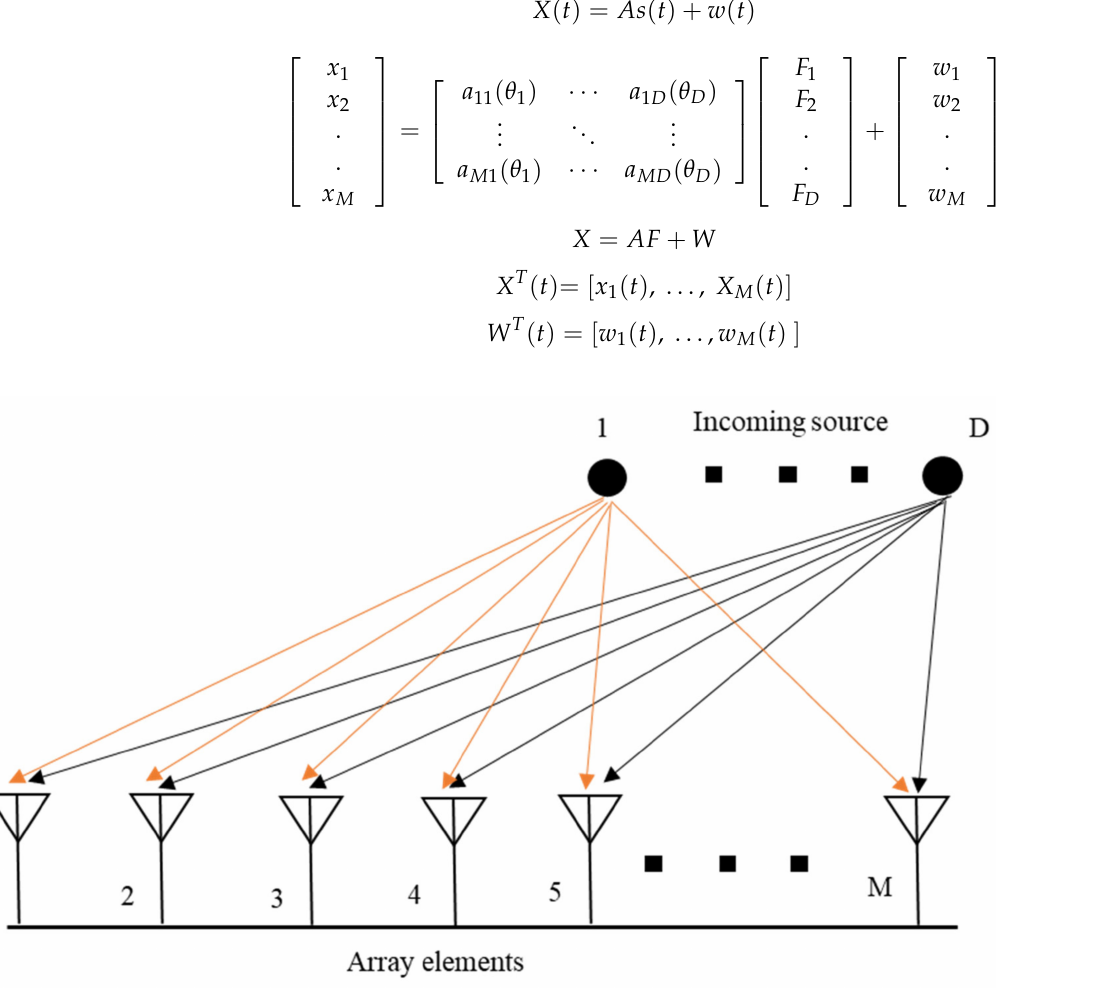
Figure 1. DOA estimation using the MUSIC